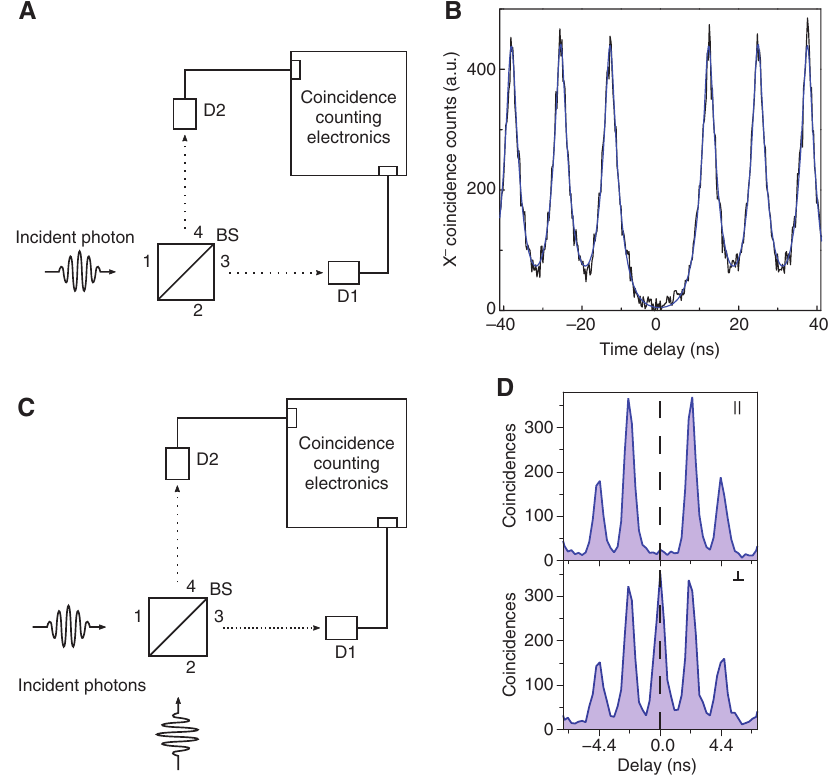
Figure 1: HBT and HOM measurements. (A) HBT measurement scheme for characterizing single-photon purity. (B) Example HBT measurement result obtained with pulsed excitation of the nanowire SPS reported in Ref. [44] (the blue solid line is a fit to the measured data). (C) HOM measurement scheme for characterizing indistinguishability. (D) Example HOM measurement result obtained with pulsed resonant excitation of the micropillar SPS reported in Ref. [47] and inducing either parallel or perpendicular polarization between the two input modes of the beamsplitter. Figure reprinted with permission from: (B) Ref. [44], 2016 by the American Physical Society; (D) Springer Nature, Nature Photonics, Ref. [47],